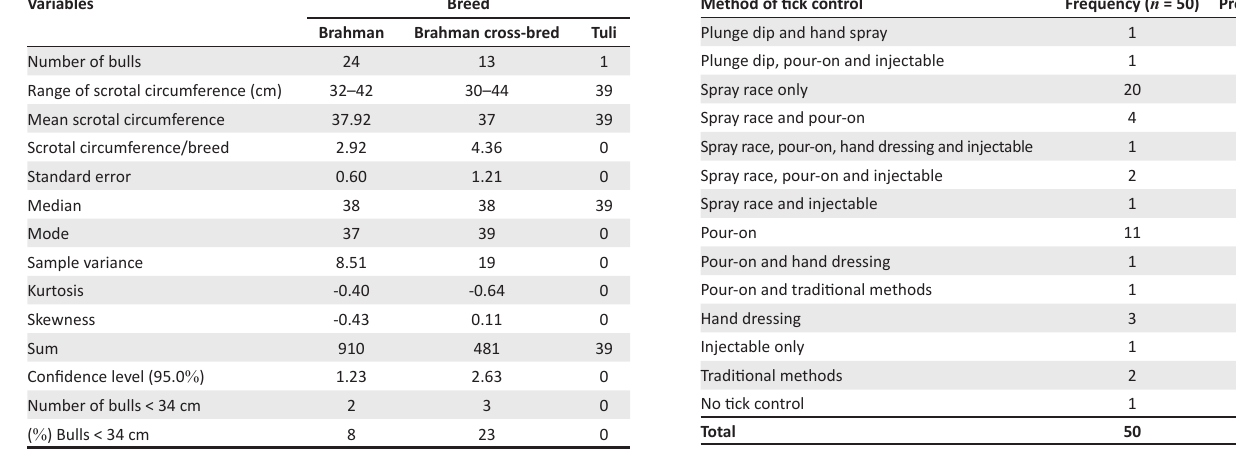
TABLE 1: Scrotal measurements of bulls ( n = 38) per breed during breeding soundness evaluation (Maime 2016).